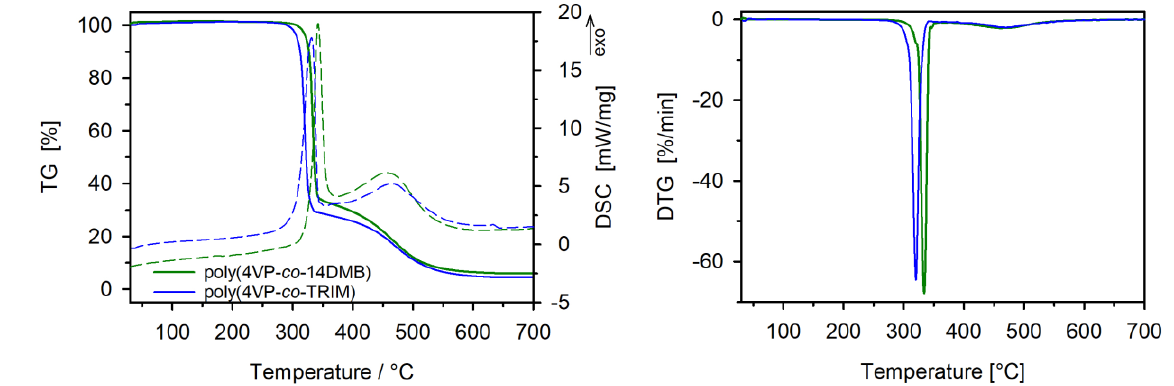
Figure 6. TG and DTG curves and DSC thermograms for 4VP copolymers. Table 2. Parameters characterizing the thermal stability of 4VP